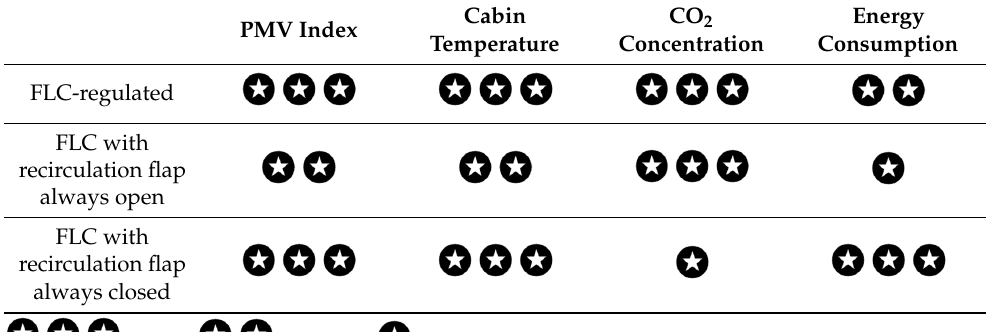
Table 8. An overview of the performance indicators of the vehicle HVAC controllers under test.